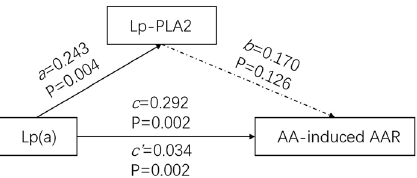
Figure 5. Mediation models of Lp-PLA2 in Lp(a) and AA-induced AAR. The direct effect of Lp(a) on AA-induced AAR ( c ) was significant and estimated to be 0.292 with p = 0.126. The direct effect of Lp(a) on Lp-PLA2 ( a ) was significant and estimated to be 0.243 with p = 0.004. The direct effect of Lp-PLA2 on AA-induced AAR ( b ) was insignificant and estimated to be 0.170 with p = 0.126. The total effect of Lp(a) on AA-induced AAR ( c ′ = c + ab ) was significant and estimated to be 0.034 with p =